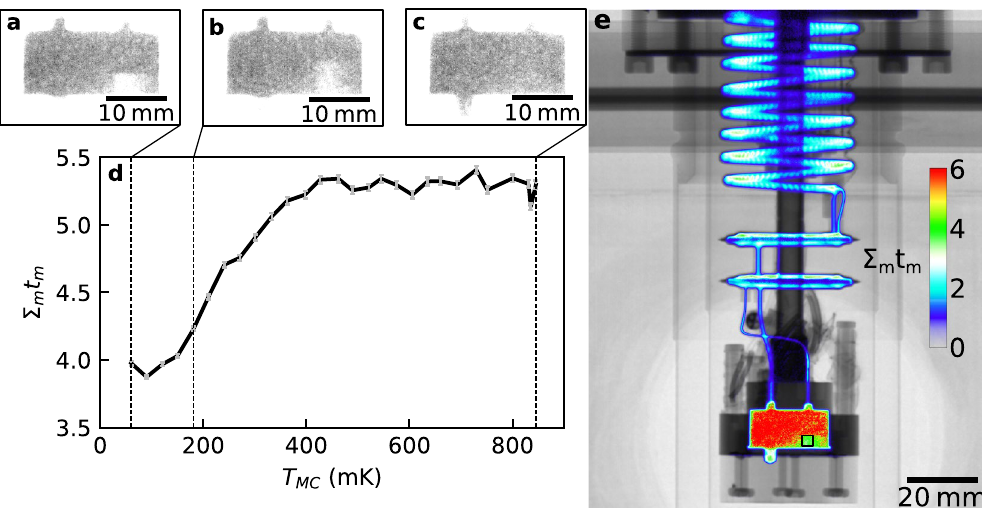
Figure 3. Changing 3 He concentration with temperature in the mixing chamber of the DR. Panels ( a – c ) show neutron images of the mixing chamber of the DR at the three temperatures indicated in ( d ), which is a plot of the quantity Σ m t m against mixing chamber temperature. Note how Σ m t m increases with temperature, indicating further attenuation of the neutron beam and hence greater 3 He concentration in the dilute phase; and the phase boundary moves upwards, as expected because of the resulting redistribution of the mixture. The standard deviation of each data point in ( d ) is shown by the vertical error bars. Panel ( e ) shows the quantity Σ m t m throughout the entire dilution refrigerator circuit for a mixing chamber temperature of 60 mK and indicates the measurement position for the graph in ( d ) with the black square at the lower-right of the mixing chamber.